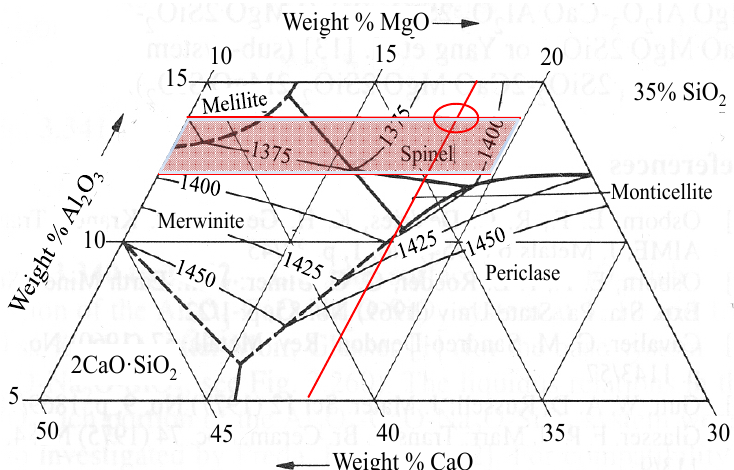
Figure 5. Phase diagram of the CaO–SiO 2 –MgO–Al 2 O 3 quaternary slag system (SiO 2 = 35%) [1] .